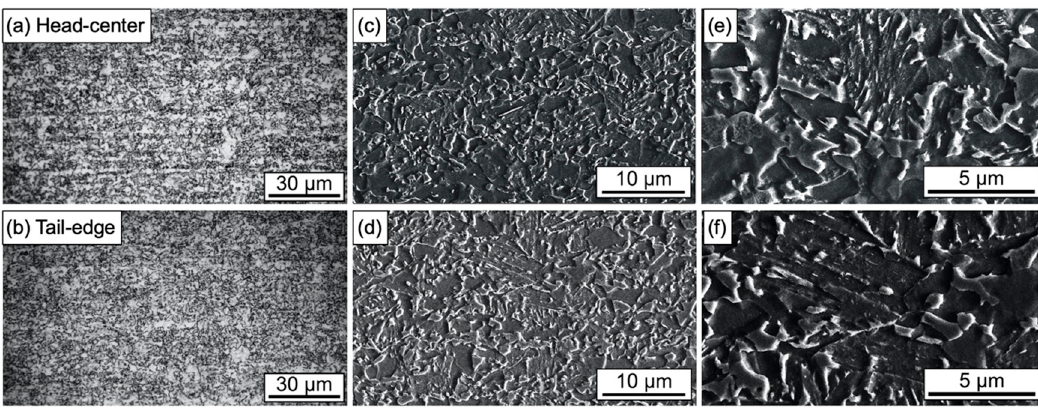
Figure 6. Microstructure of cold rolled steel after final conditioning: ( a , b ) light optical microscopy; ( c , d ) scanning electron microscopy; ( e,f ) SEM (scanning electron microscopy) higher magnification.